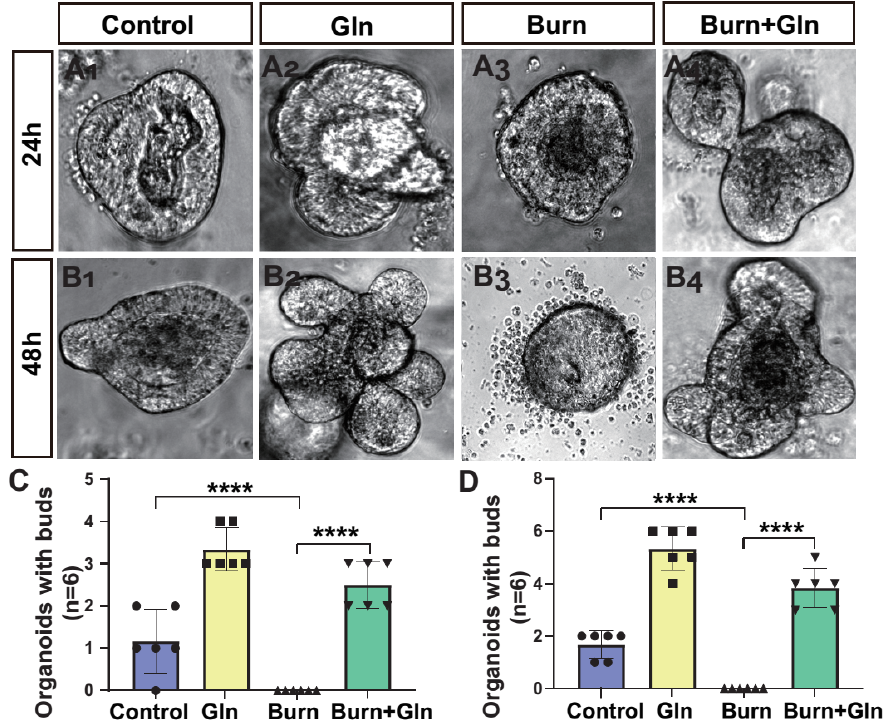
Figure 2. Regeneration of the organoids of the mouse small intestine crypts after Gln treatment. ( A 1 – A 4 ) are representative images of the organoids of the mouse small intestine crypt in control group, Gln group, Burn group and Burn+Gln group 24 h after burns injury. ( B 1 – B 4 ) are representative images of the organoids of the mouse small intestine crypt in control group, Gln group, Burn group, and Burn+Gln group 48 h after burns injury. ( C ) Comparison of the number of budding crypts in a single organoid of the mouse small intestine crypt 24 h after burns injury. ( D ) Comparison of the number of budding crypts in a single organoid of mice small intestine crypt post burns 48 h. Data were expressed as mean ± SEM from 6 independent experiments ( n = 6). **** p < 0.0001 using 1-way ANOVA and post hoc Tukey’s